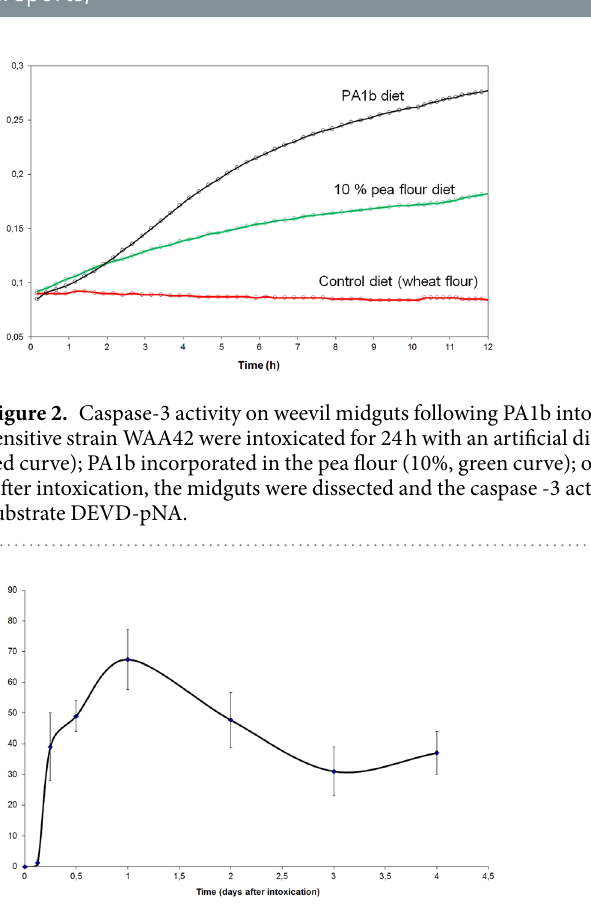
Figure 3. Induction kinetics of the caspase-3 activity by PA1b. The weevils of the PA1b sensitive strain WAA42 were intoxicated for different time periods (0, 3, 6, 12, 24, 48, 72 and 96 h) with an artificial diet composed of wheat flour incorporating PA1b (400 µ g/g of food). After intoxication, the midguts were dissected and the caspase -3 activities were measured using the artificial substrate